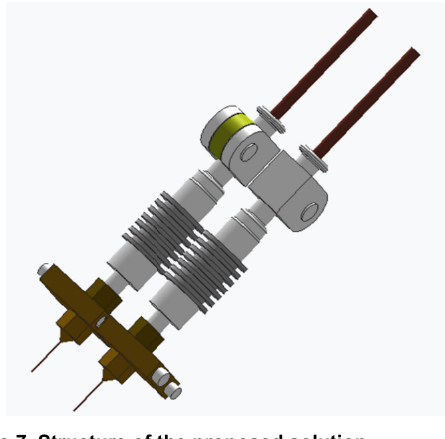
Figure 7. Structure of the proposed solution